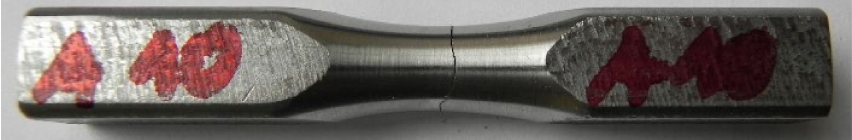
Figure 1. The test stand used to test 16Mo3 steel under oscillatory bending conditions.